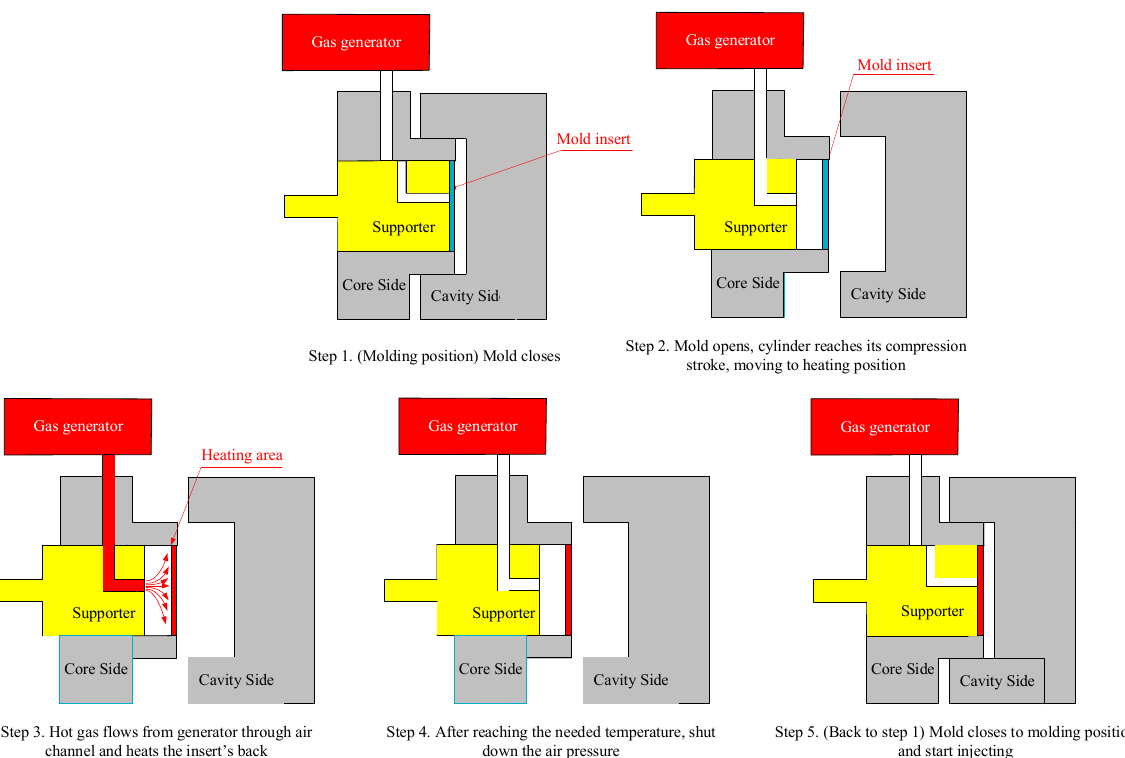
Figure 2. Mold position in the heating stage of the In-GMTC process.